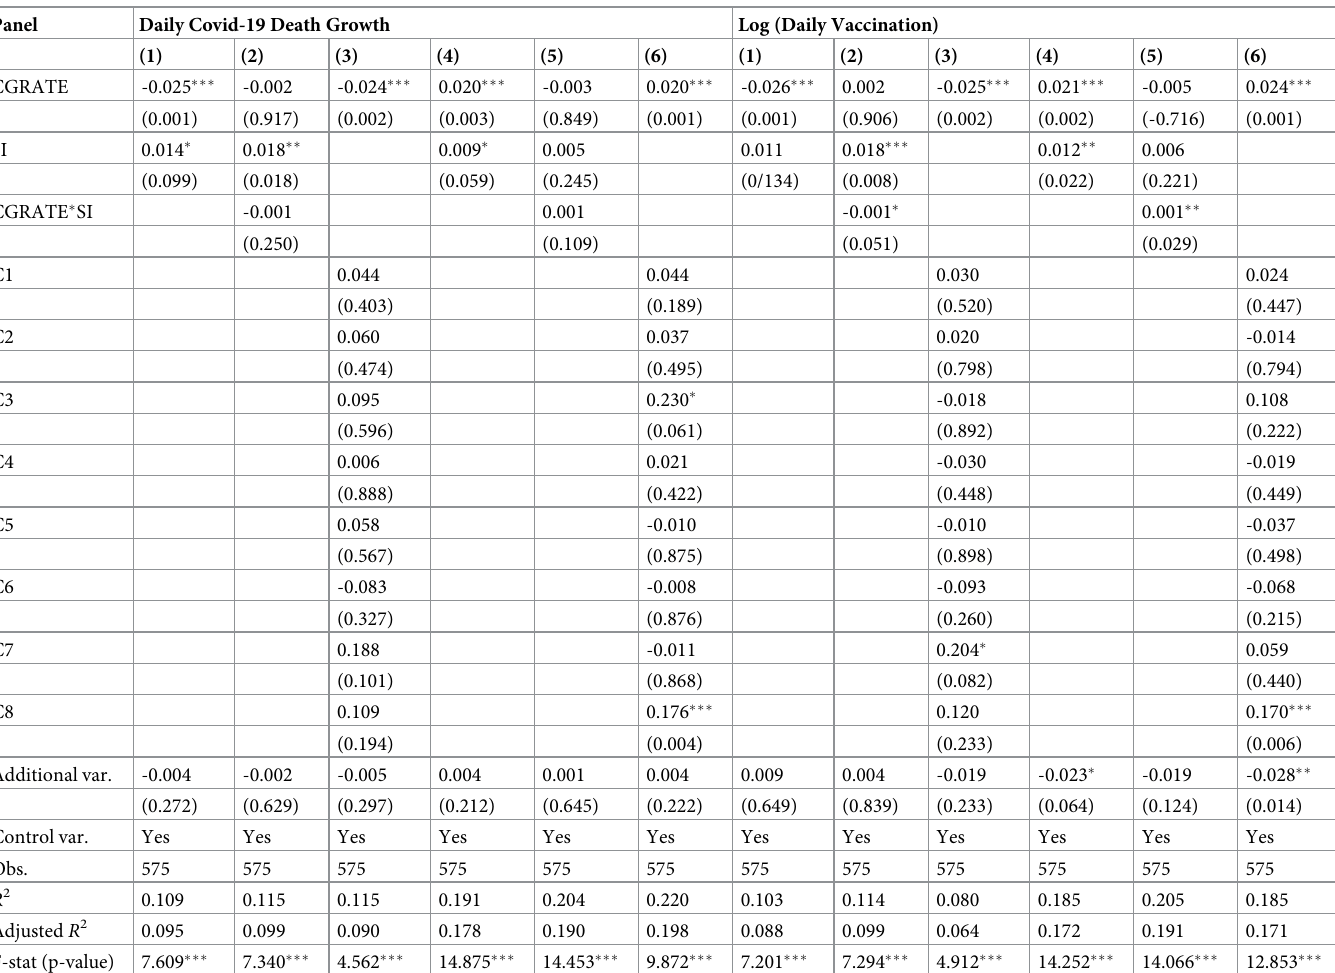
Table 10. Robustness tests: Additional control